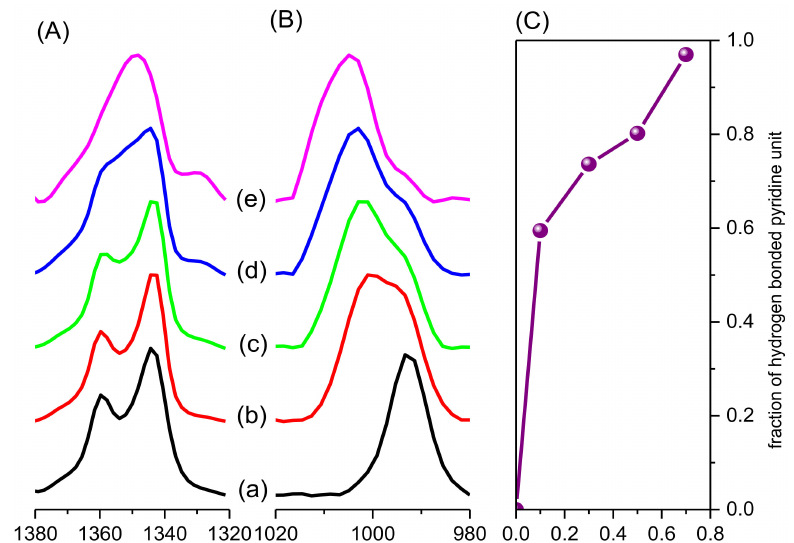
Figure 7. FTIR analyses of PS- b -PVPh/PEO-b-P4VP mixture of ( A ) CH 2 wagging, ( B ) pyridine vibration of (a) 0/100, (b) 10/90, (c) 30/70, (d) 50/50, (e) 70/30, and ( C ) fraction of hydrogen bonded pyridine unit with different PS- b -PVPh weight